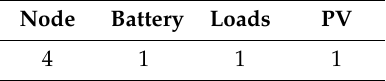
Table A1. Number of nodes and the microgrid